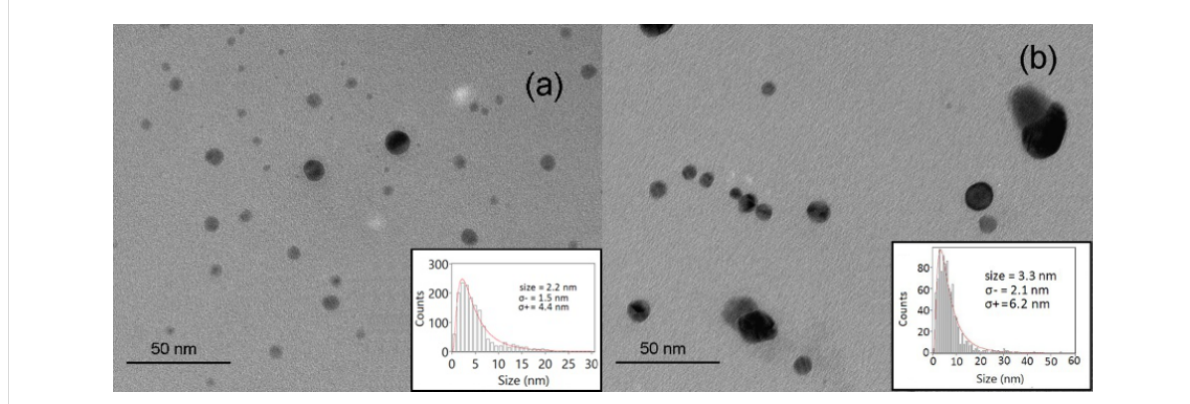
Figure 2: Typical TEM image and size (average diameter) distribution of (a) AgNPsH 2 Ops and (b) AgNPsLiClps.